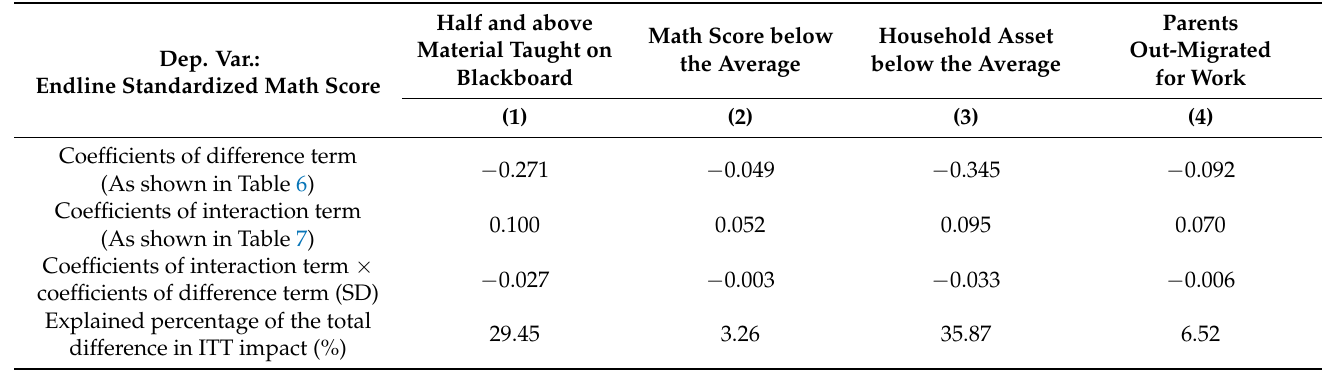
Table 8. Explained percentage of the total difference in ITT impact by baseline